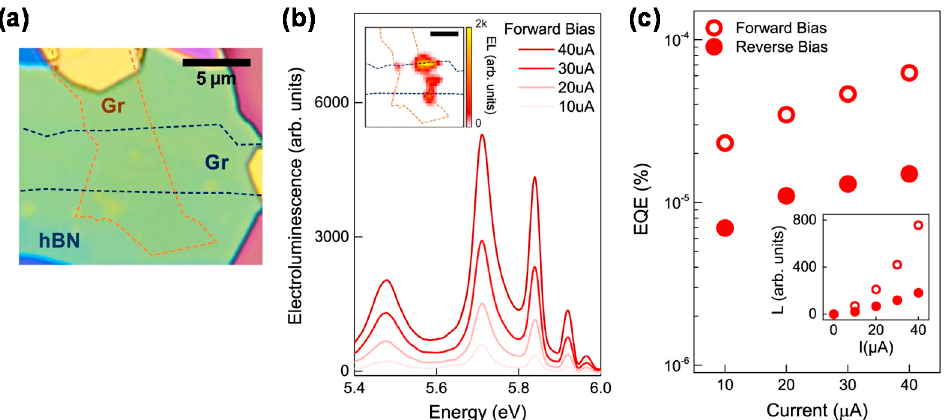
Figure 6. ( a ) Optical microscope image of the graphene/hBN/graphene van der Waals (vdW) heterostructure. ( b ) Deep ultraviolet (DUV) electroluminescence spectra under forward bias. ( c ) Dependence of the external quantum efficiency (EQE) of electroluminescence on current. Adapted from [48] under CC BY 4.0.